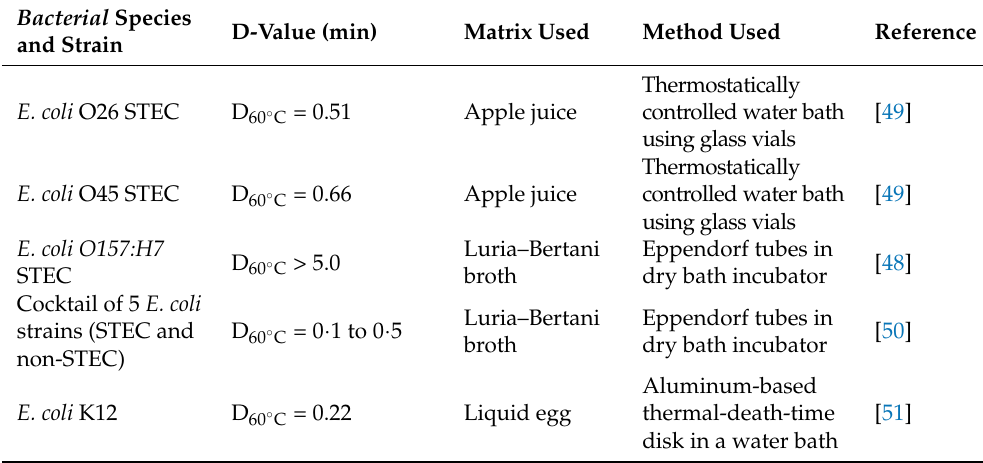
Table 4. Summary of D-values (thermal resistance) for E. coli (STEC) and non-STEC strains in the literature along with the matrix used.